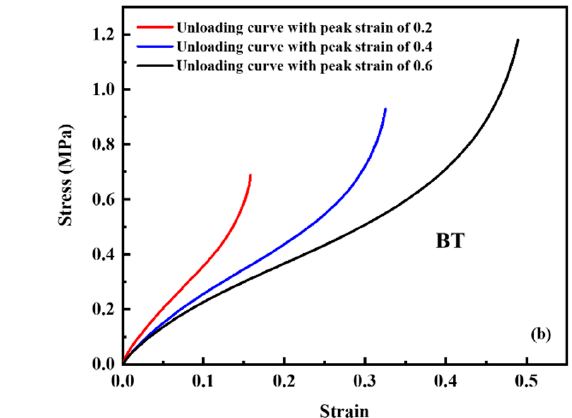
Figure 6. ( a ) The final adjusted unloading stress–strain curve at five peak strain levels of UT, and ( b ) the final adjusted unloading stress–strain curve at three peak strain levels of BT.